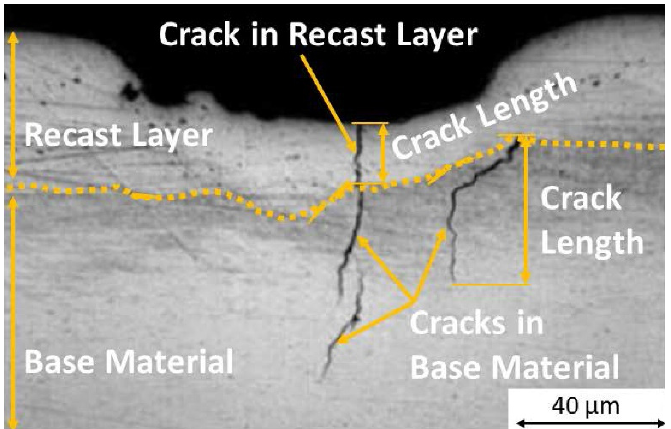
Figure 1. The crack formed in the recast layer and its propagation into the base material.